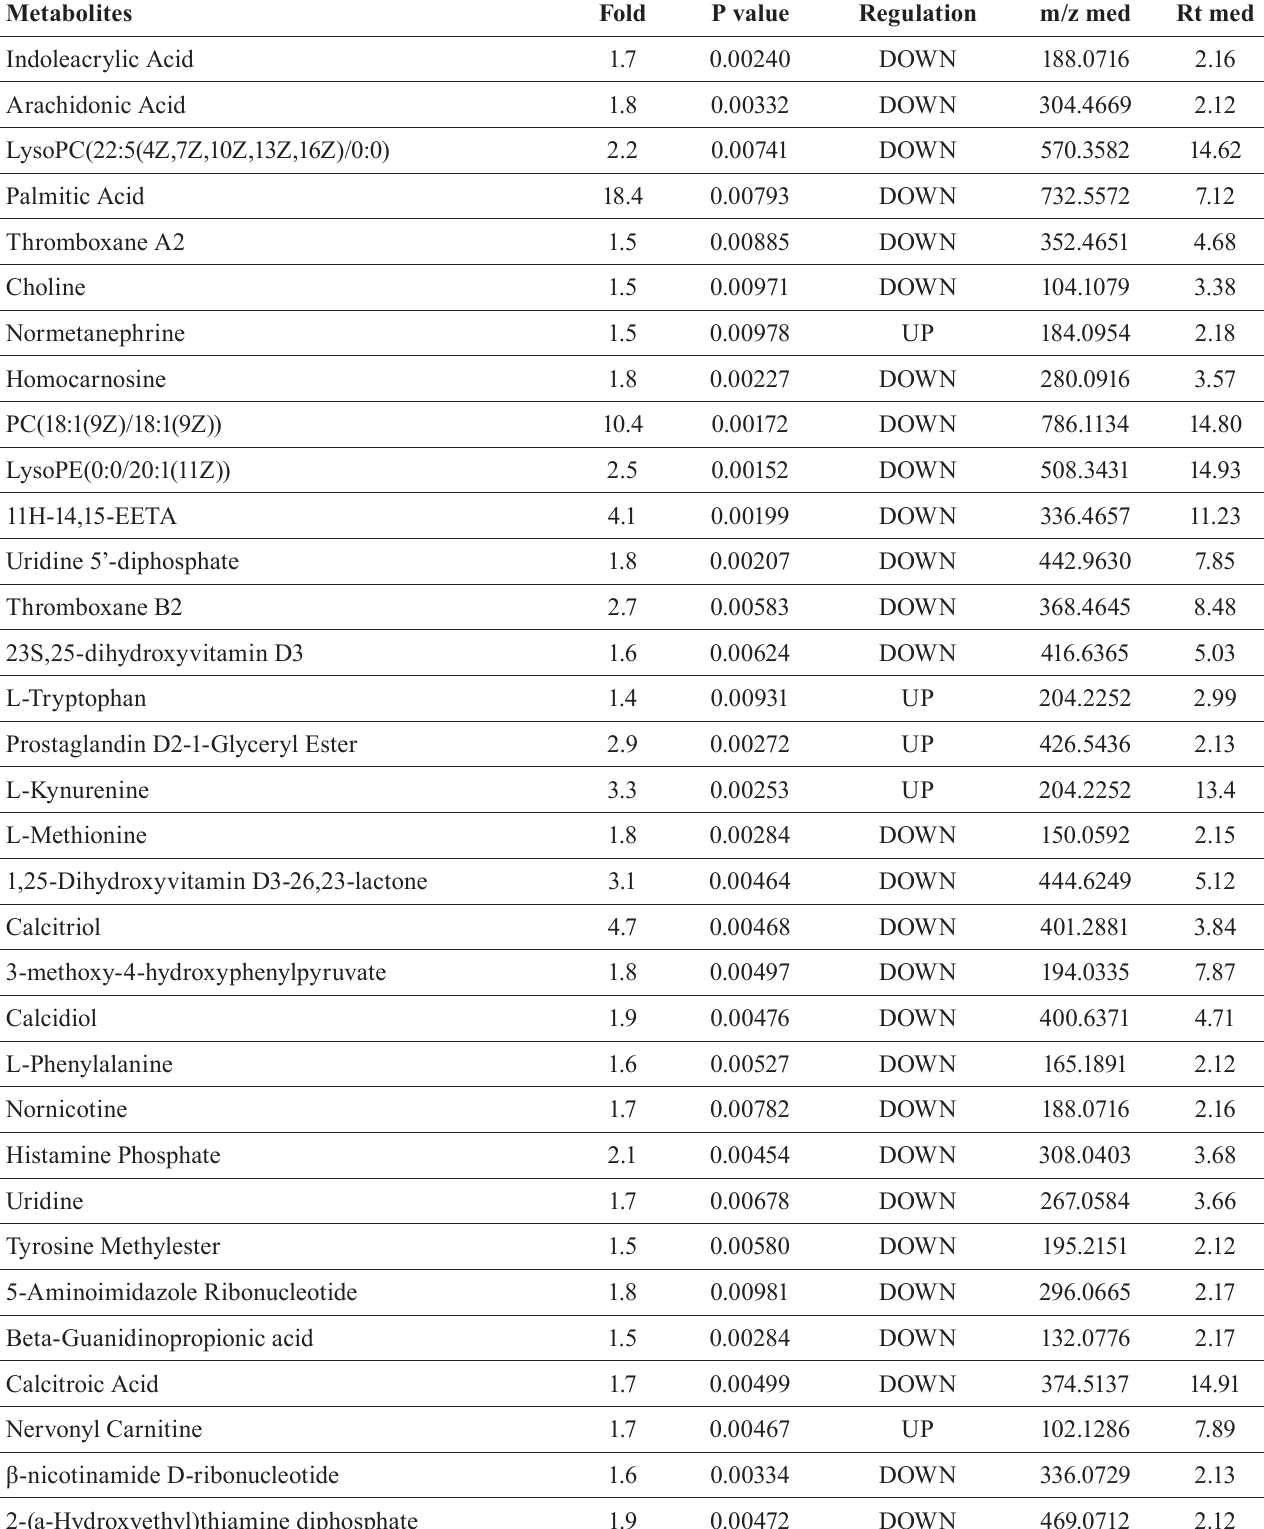
TABLE I - L ist of the significantly different metabolites identified in the drug group compared to the control group Metabolites Fold P value Regulation m/z med Rt